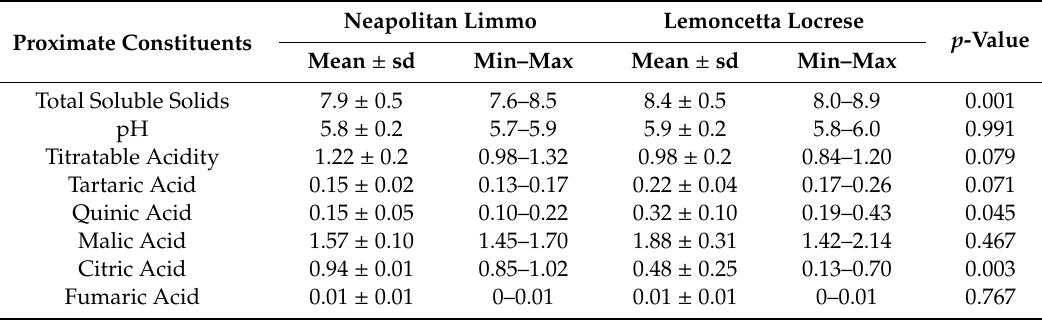
Table 2. Proximate constituents. pH, soluble solids (°Brix), titratable acidity (as citric monohydrate acid g/L), and organic acids (g/L) in Neapolitan limmo and lemoncetta Locrese.